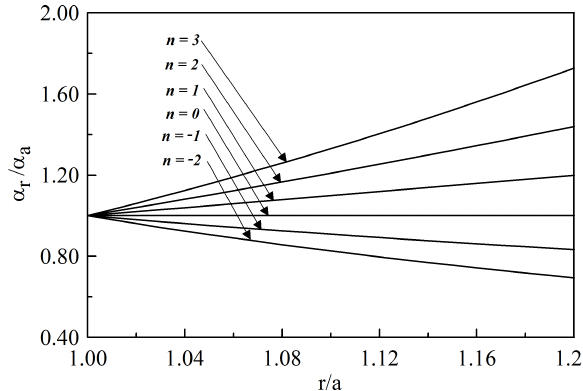
Figure 3: Radially distributed thermal expansion coeflcient